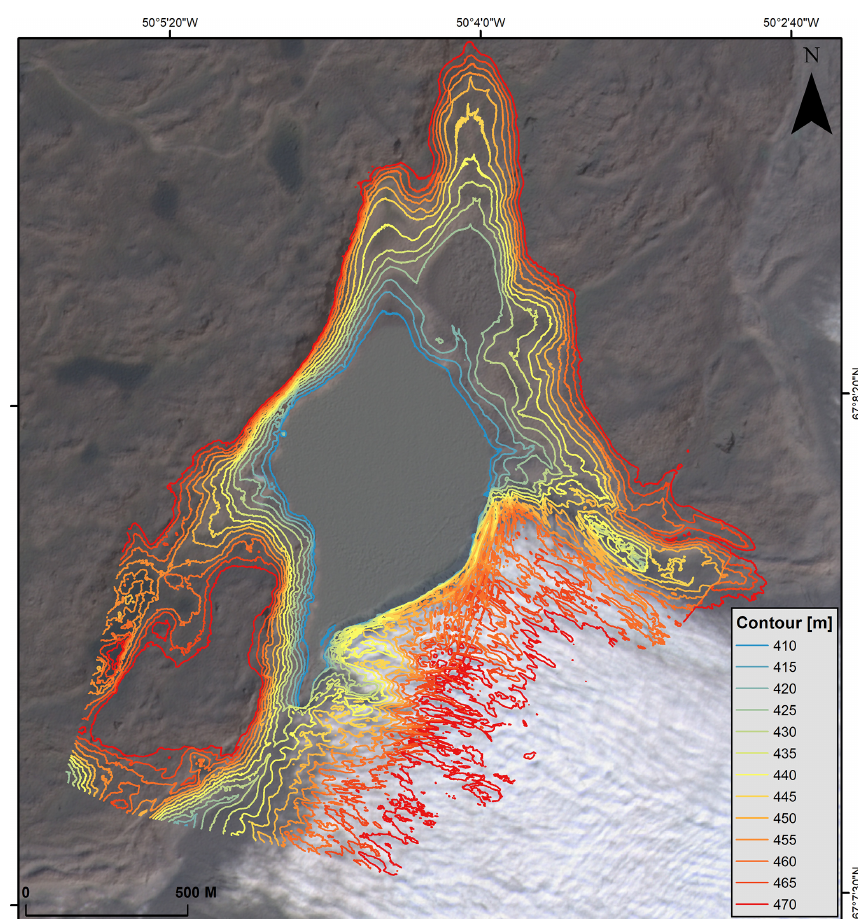
Figure A1. Contour map with 5m intervals based on the 2021 post-drainage DEM. Background is a four-band Planet Team (2017) acquisition from 23 August